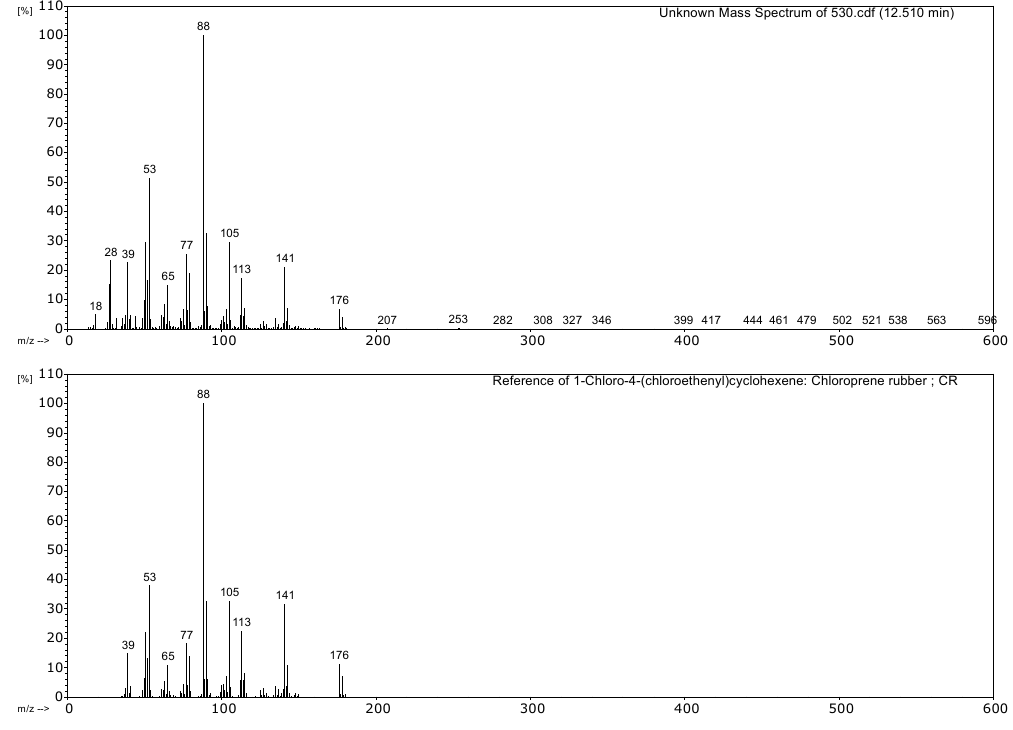
Figure 16. Mass spectrum of peak eluting at 12.51 min in the pyrogram of sample 530, along with a reference spectrum (F ‐ Search database).